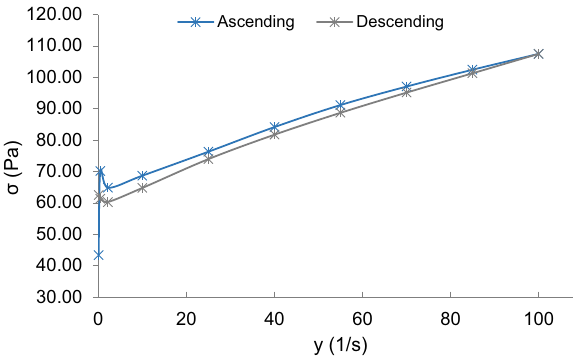
Figure 3: Example of rheology test fl ow curves analyzed from the ascending and descending cycle.